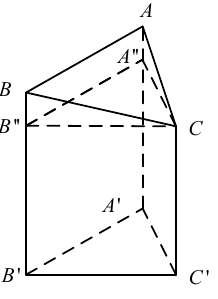
Figure 4. Triangular patch composite model.